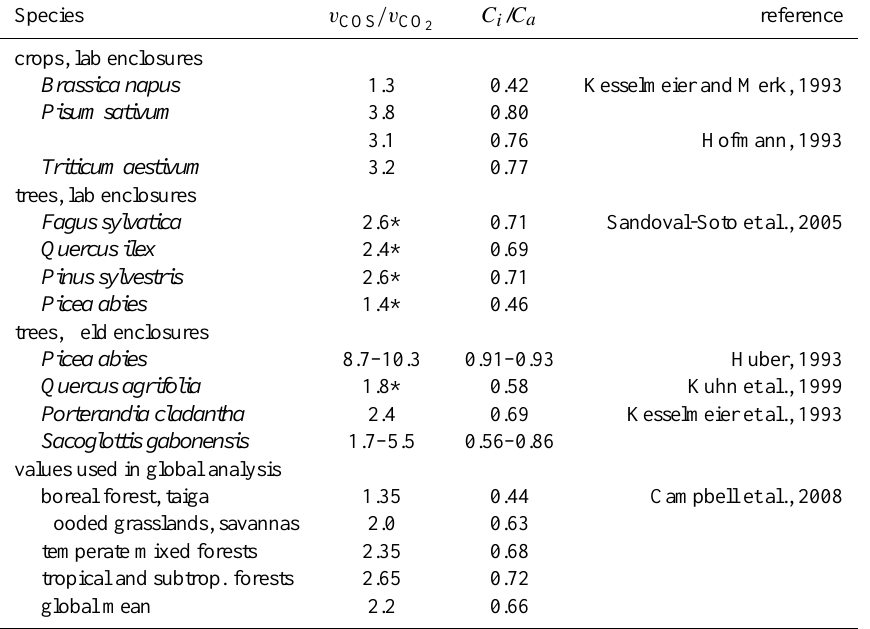
Table 2. Normalized uptake ratios of COS to CO 2 ( v COS /v CO ) and their corresponding C i / C a ratios (based on Eq. (9), g s COS /g i COS =0.1) 2 for published data (Sandoval-Soto et al., 2005), and ecosystem types used to estimate global COS uptake by vegetation (Campbell et al., 2008). Note that for published data from enclosure studies (except those recalculated from original data, indicated by *), v COS /v CO calculated from reference (or atmospheric) COS and CO 2 mole fractions. As the mole fractions of the air surrounding the leaves (i.e. chamber air) should be used instead, their actual v COS /v CO values could be 10 to 15% higher than listed in the 2